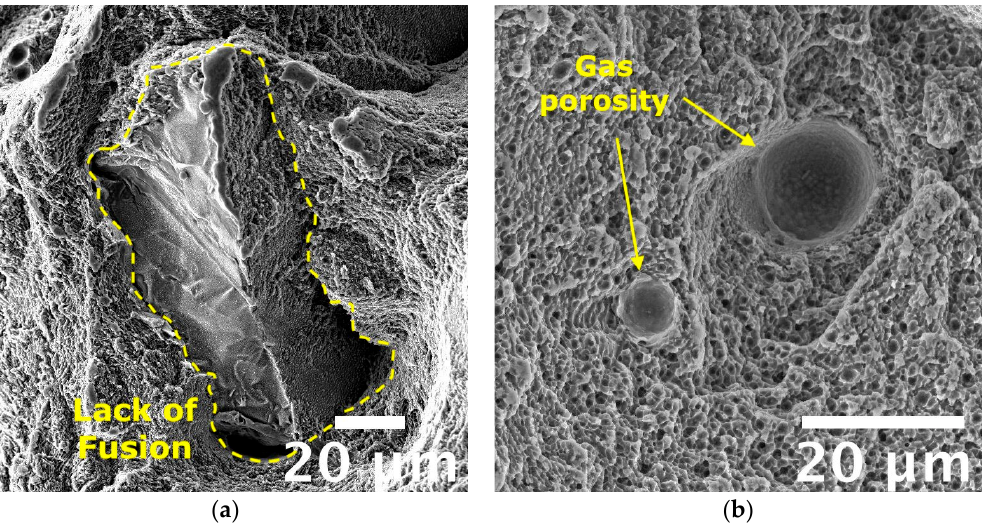
Figure 15. FEG-SEM high magnification fractographic analyses of the AlSi7Mg alloy tensile samples show the main defects affecting mechanical behavior: ( a ) lack of fusion and ( b ) gas porosities.